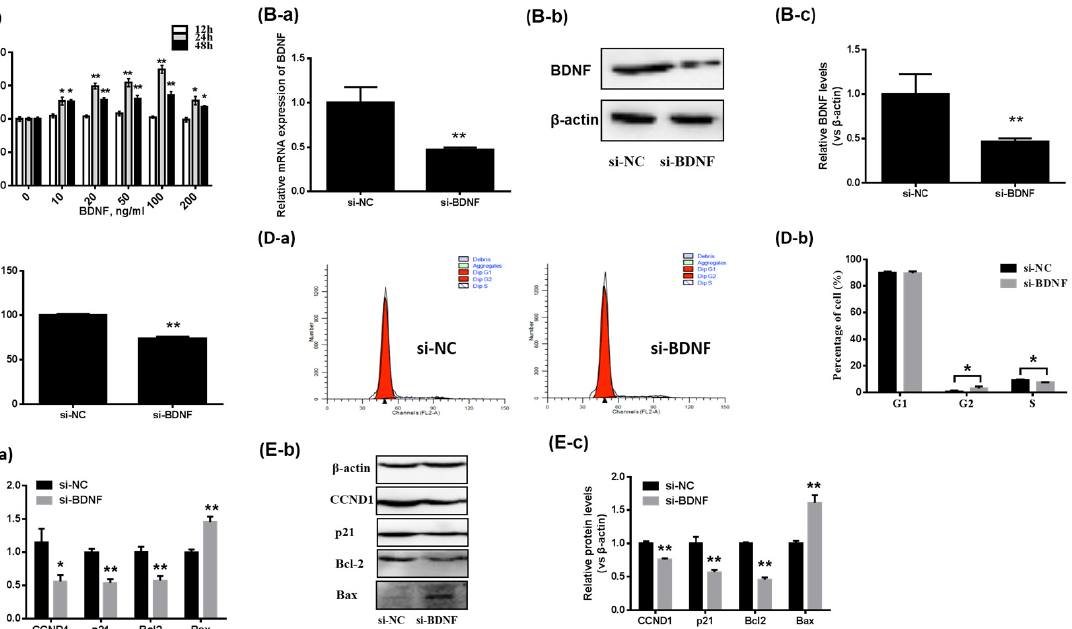
Figure 1. Effects of BDNF on the proliferation of porcine GCs. ( A ) Porcine GCs are cultured with various concentrations of BDNF (0, 10, 20, 50,100, 200 ng/mL) for different times (12, 24, 48 h); CCK-8 assay is performed to examine GC viability. ( B ) Porcine GCs are transfected with si-BDNF or nonspecific siRNA (si-NC) for 24 h. RT-qPCR and Western blotting are performed to assess mRNA ( B-a ) and protein ( B-b , B-c ) expression levels of BDNF. ( C ) GC viability is examined by CCK-8 after BDNF knockdown. ( D-a , D-b ) The distribution of cell cycle in porcine GCs is determined using FACS. ( E ) The mRNA ( E-a ) and protein ( E-b , E-c ) expression levels of Bcl2, Bax, p21 and CCND1 are detected by RT-qPCR and Western blotting after transfection with si-BDNF for 24 h. Data are presented as mean ± SD, n = 3; * p < 0.05, ** p < 0.01. BDNF, brain-derived neurotrophic factor; Bcl-2, B-cell lymphoma-2; Bax, Bcl2-Associated X; p21, cyclin-dependent kinase inhibitor 1A; CCND1, cyclin D1.